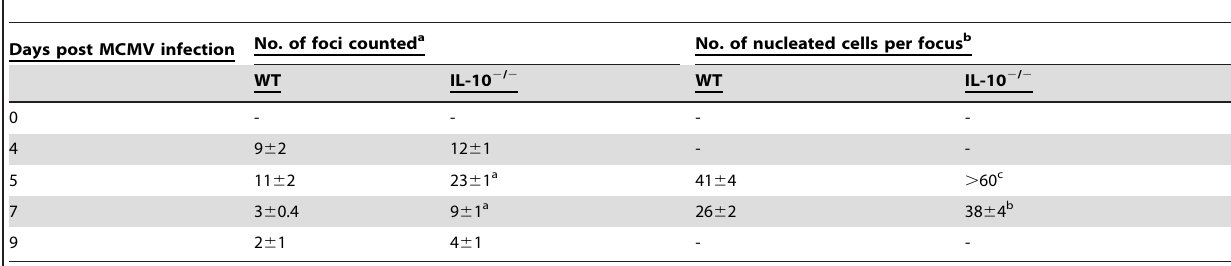
Table 1. Quantitation of inflammatory foci in MCMV infected C57BL/6J (WT) and IL-10 2 / 2 livers.